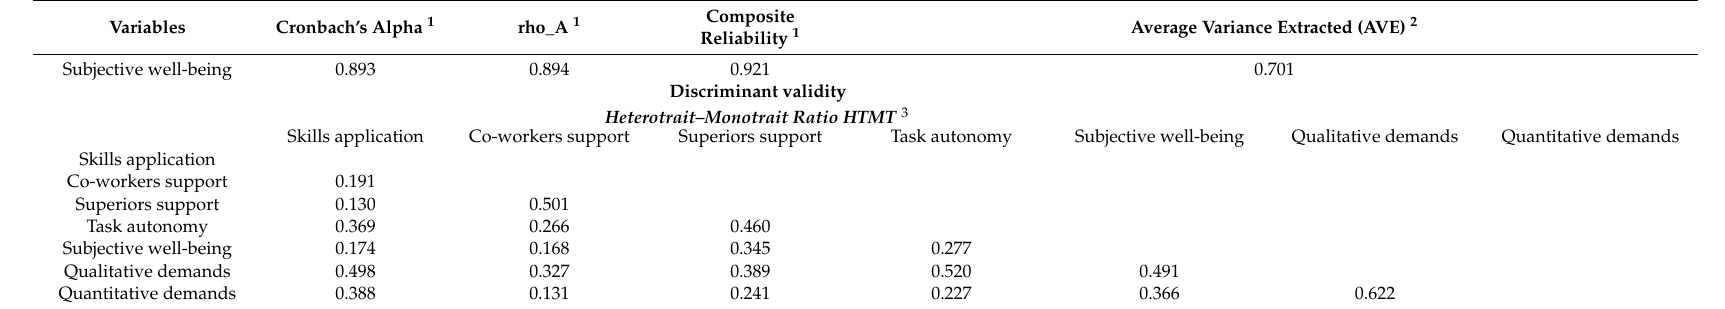
Table 2. Construct Reliability. Convergent validity and discriminant